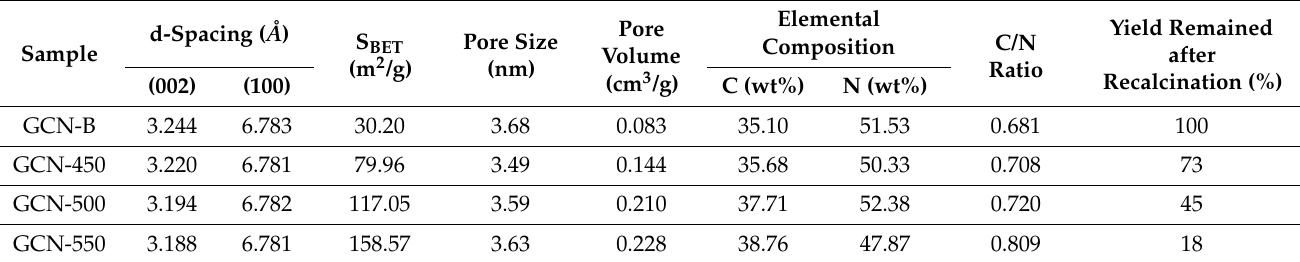
Table 1. The specific surface area, pore size, and elemental composition of GCN-B and GCNs that recalcined at different temperatures.